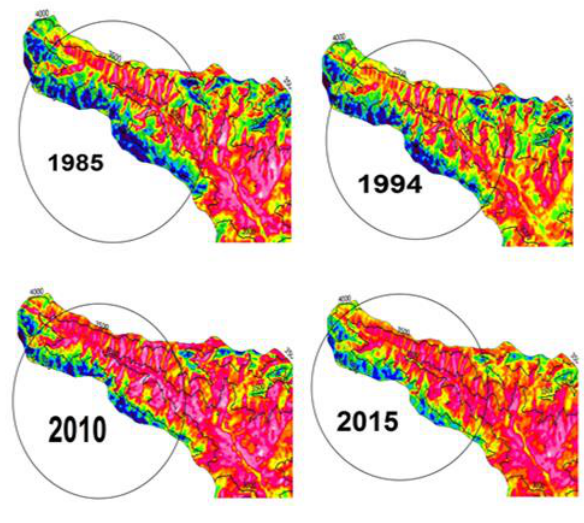
Figure 8. LST of snow patches (°C)